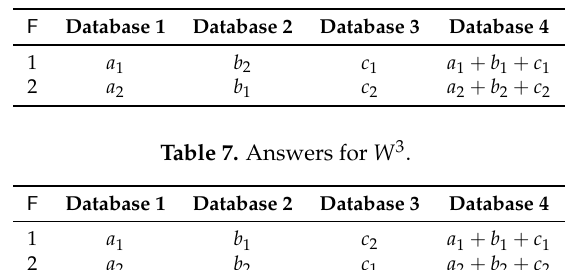
Table 6. Answers for W 2 .